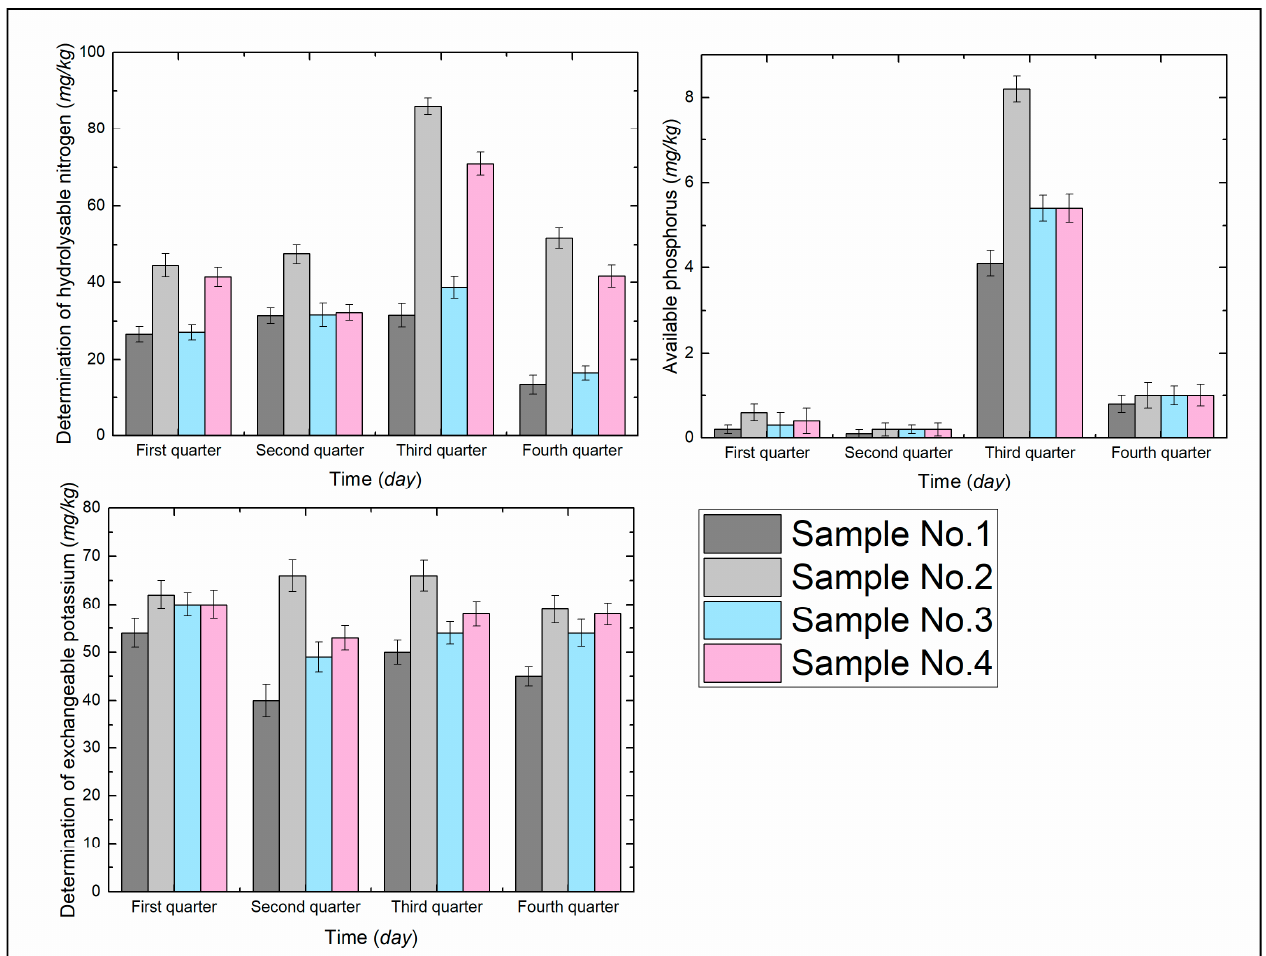
Figure 5. Available nutrients content of the